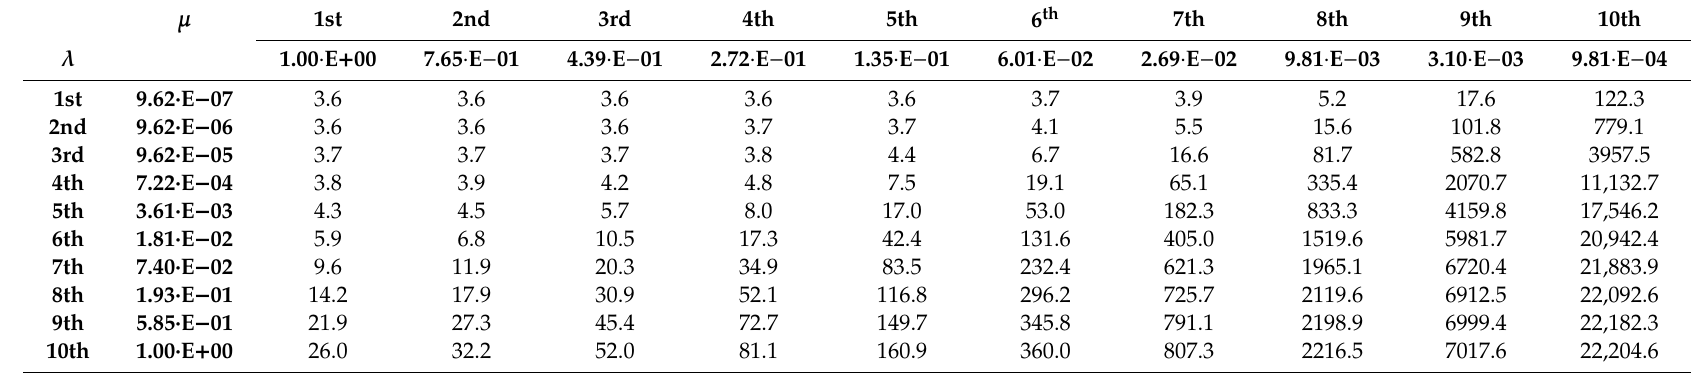
Table A1. Risk-prioritization metric ( RPM ) table with respect to the failure occurrence rate λ and failure-cause detection rate µ ( c = 1, ε = 0.0181, α = 200, β = 1000, and θ =